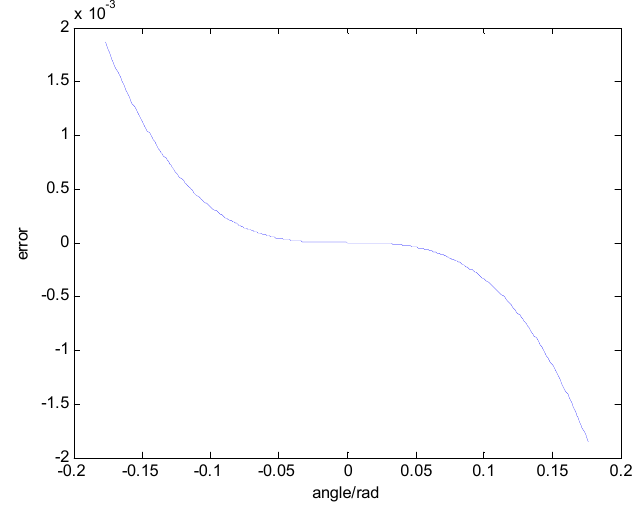
Figure 17. Approximate error caused by Equation